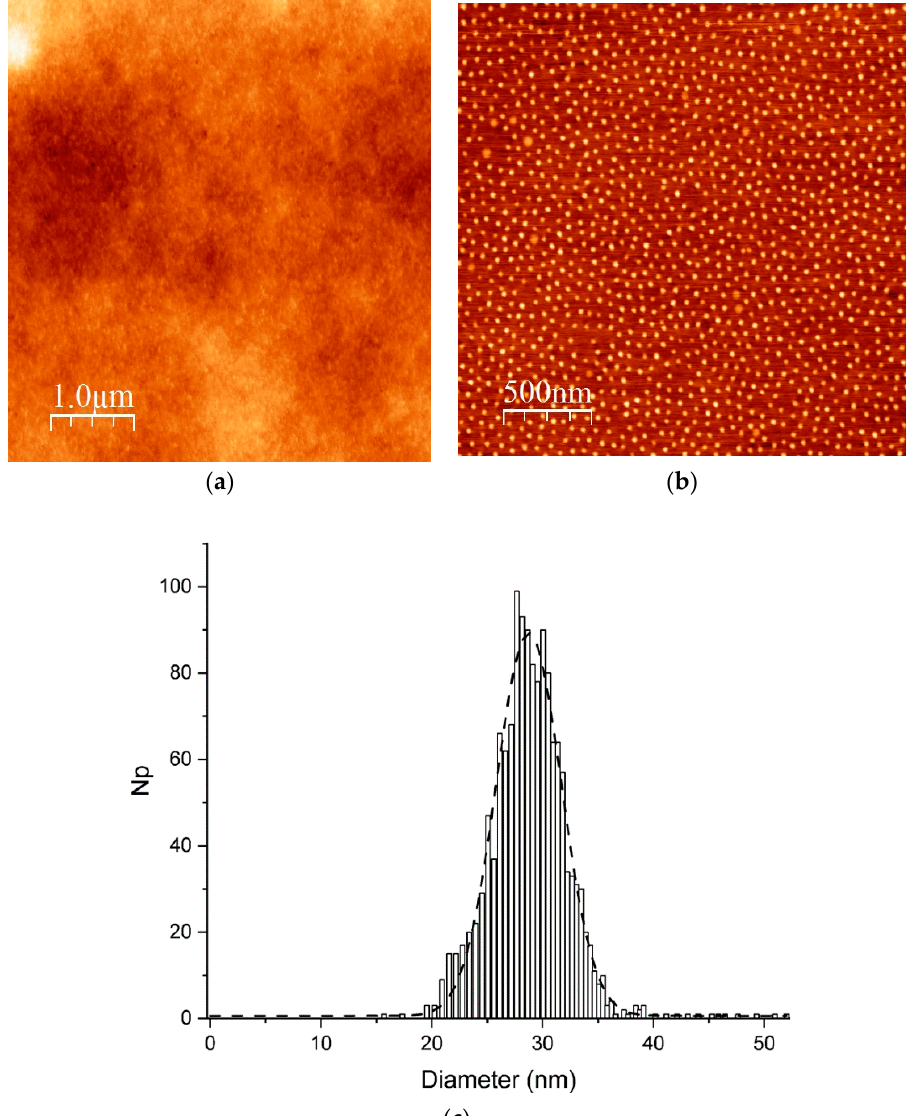
Figure 1. ( a ) AFM images of PMMA- b -PSBMA block copolymer in 2,2,2-trifluoroethanol coated on silicon wafer with 5% w / w polymer concentration, ( b ) PMMA- b -PSBMA block copolymer in 2,2,2-trifluoroethanol: water mixture 1:1 coated onto a silicon wafer with 5% w / w polymer concentration, ( c ) Particle size distribution of PMMA- b -PSBMA block copolymer built from the AFM image analysis.